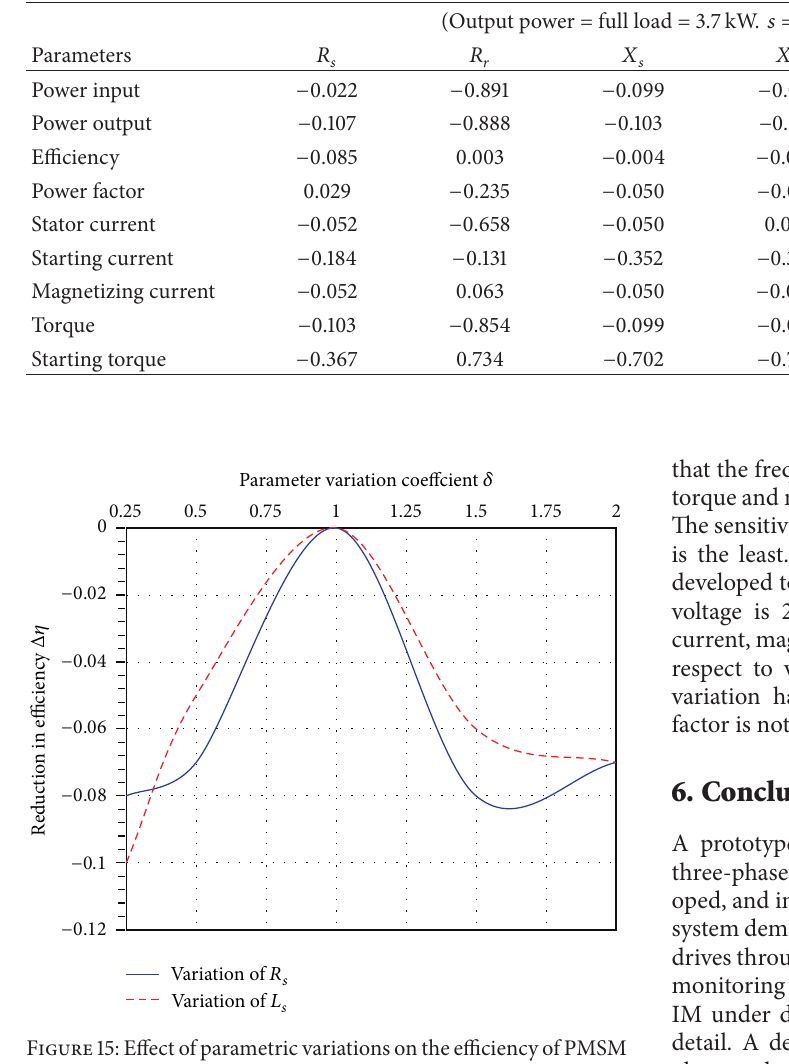
Table 3: Sensitivity of performance variables of three-phase IM.